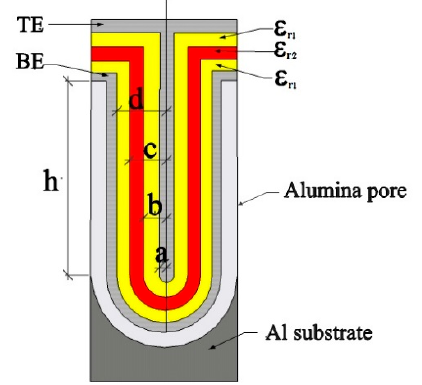
Figure 6. Schematic cross-section of the supercapacitor conductor/dielectric/conductor (C/D/C) structure across a NAAM’s pore. All the sections that make up the device are represented, starting from the aluminum substrate on which the pores are grown. Between the electrodes (TE and BE), the layers forming the dielectric material can be seen, representing those corresponding to the triple layer capacitor in this figure. The yellow color represents the SiO 2 layers and the orange represents the one of TiO 2 , indicating their relative permittivity ( ε R1 and ε R2 ) and thickness (a, b, c, and d). Note that for the single layered capacitor, instead of three dielectric layers, there would be only one, occupying the same space as the sum of the three layers.